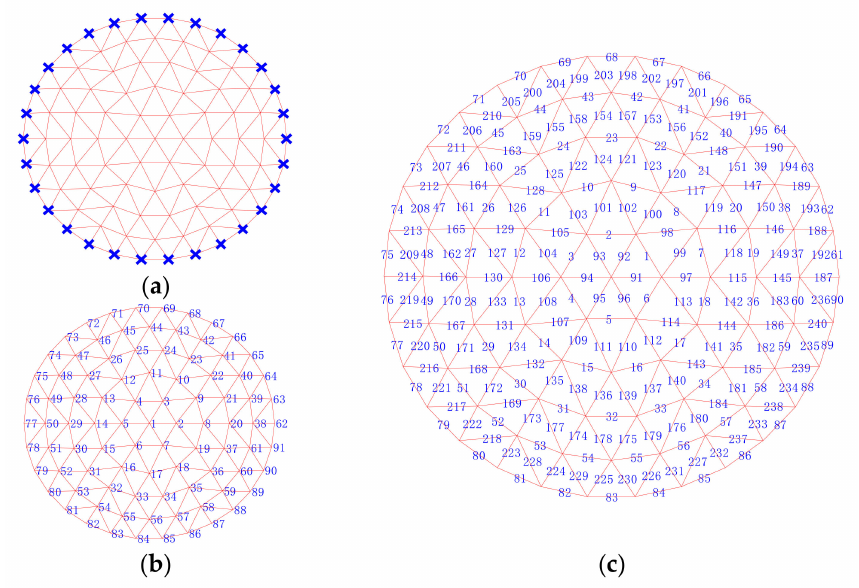
Figure 2. Long-span single-layer spherical reticulated structure: ( a ) structural model (top view); ( b ) node numbers; ( c ) element